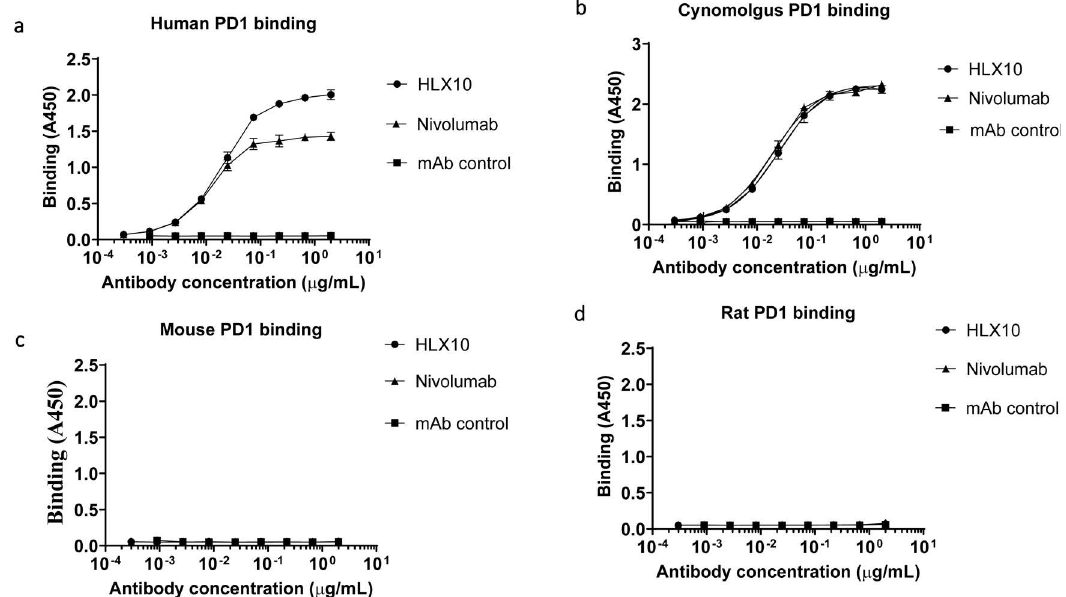
Fig 2. ELISA binding of HLX10 to PD-1 ECD from different species. The cross-reactivity of HLX10 binding to PD-1 extracellular domains (ECDs) of (a) human, (b) cynomolgus monkey, (c) mouse and (d) rat were determined using ELISA. HLX04, an unrelated human antibody mAb, was used as a negative control. All data points represent the mean man antibody